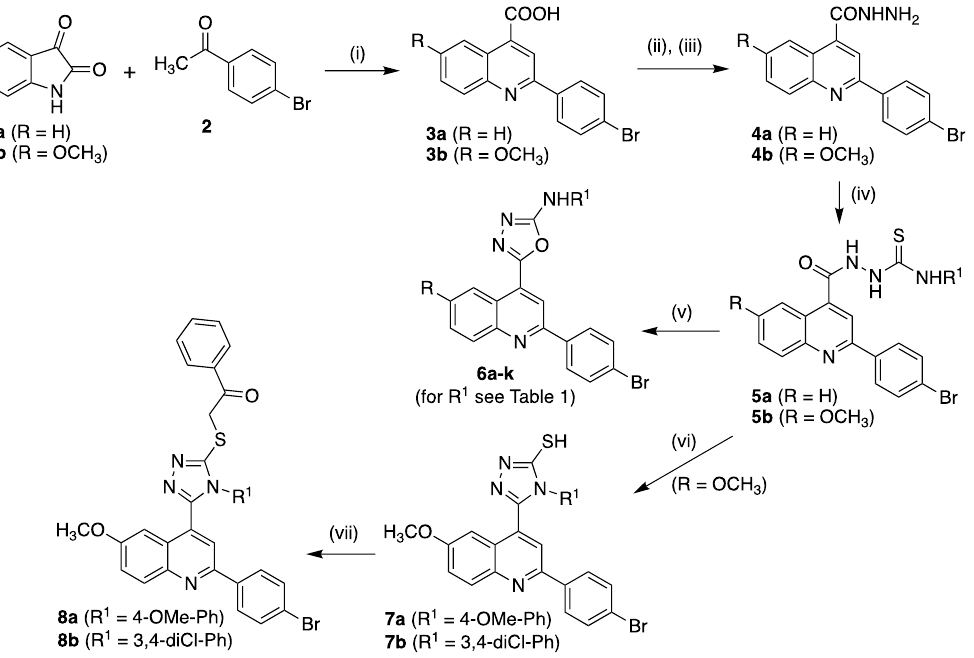
Table 1. Growth inhibitory activity (IC 50 , μM) values for quinolin-4-yl- N -aryloxadiazol-2-amines (